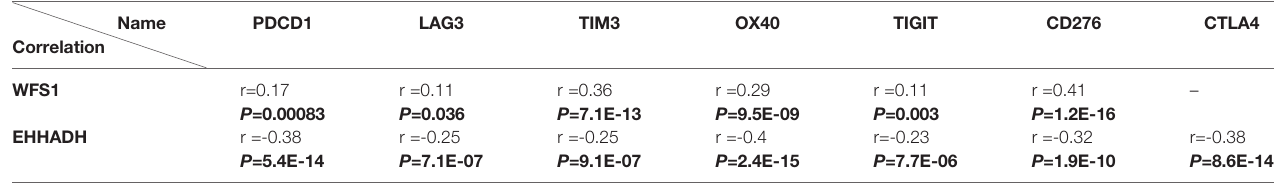
TABLE 2 | Correlation of WFS1 and EHHADH expression with PDCD1, LAG3, TIM3, OX40, TIGIT, CD276, and CTLA4 expression in HCC.